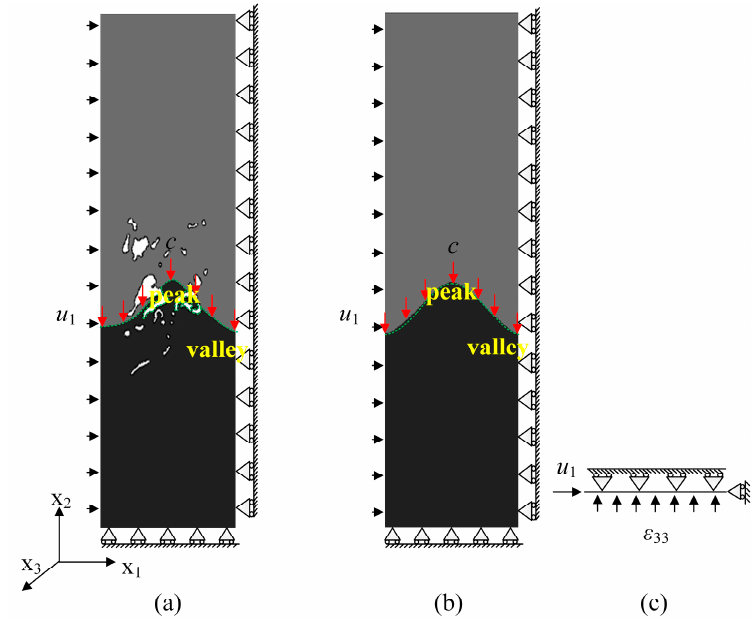
Figure 3. Boundary conditions for the two dimensional FE mesh with ( a ) cosine-interface and ( b ) actual microstructure features; and ( c ) Top view image of FE mesh.